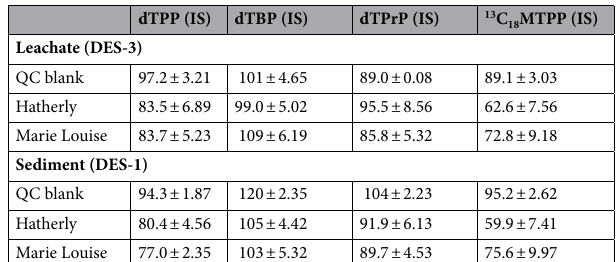
Table 4. Mean (n = 2) spiked surrogate percentage recoveries of real and blank leachate and sediment samples extracted using DES-1 and choline DES-3 for extraction.